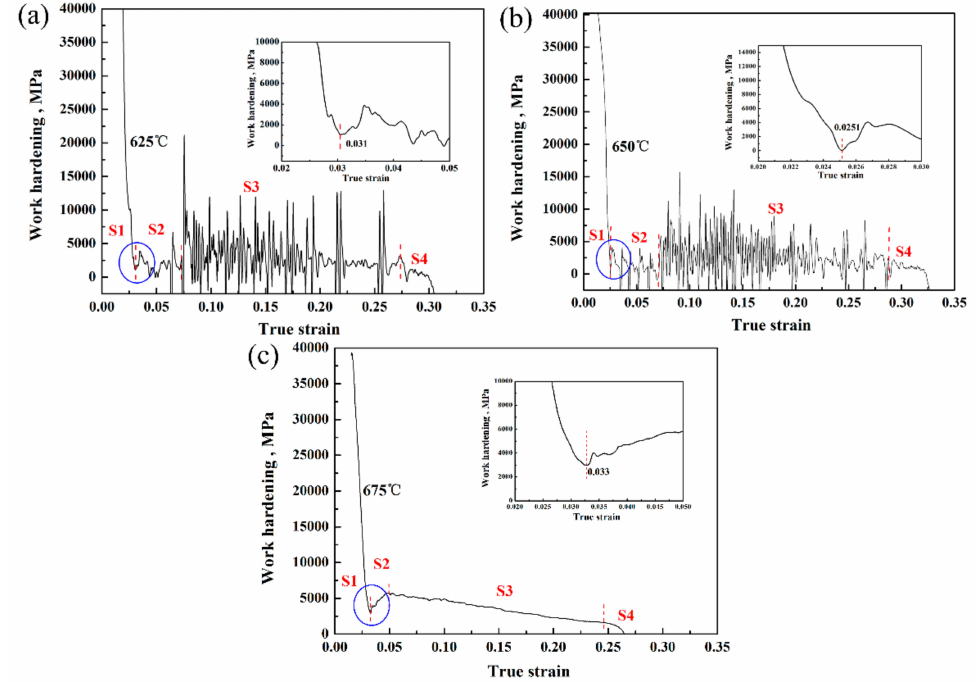
Figure 9. Work-hardening rate of samples at annealing temperatures at ( a ) 625 ◦ C, ( b ) 650 ◦ C, and ( c ) 675 ◦